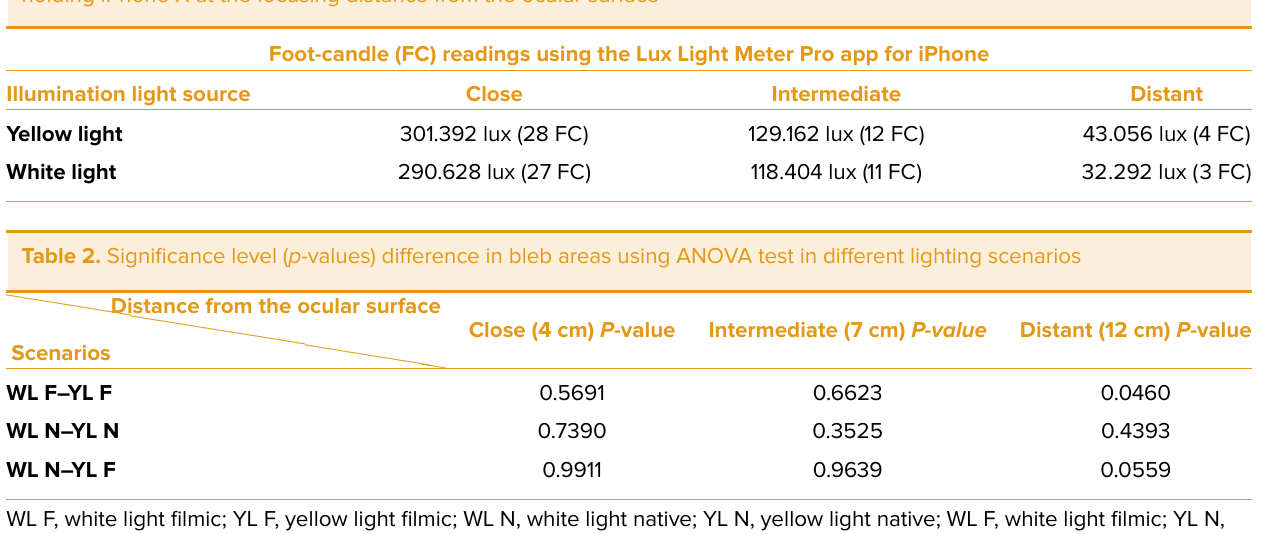
Table 1. Corrected illumination readings from the ocular surface using the Lux Light Meter Pro app for iPhone obtained by holding iPhone X at the focusing distance from the ocular surface